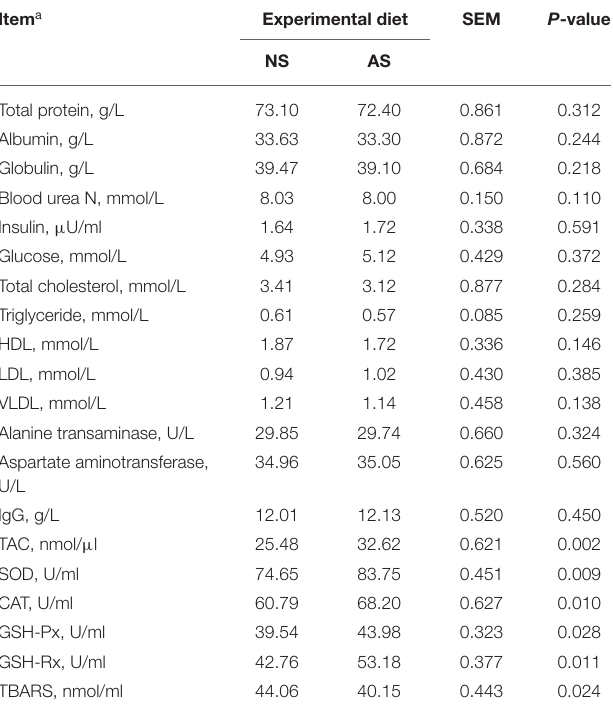
TABLE 5 | Carcass characteristics of goats fed a total mixed ration supplemented with Napier grass silage (NS) or anthocyanin-rich black cane silage (AS). Item a Experimental diet SEM